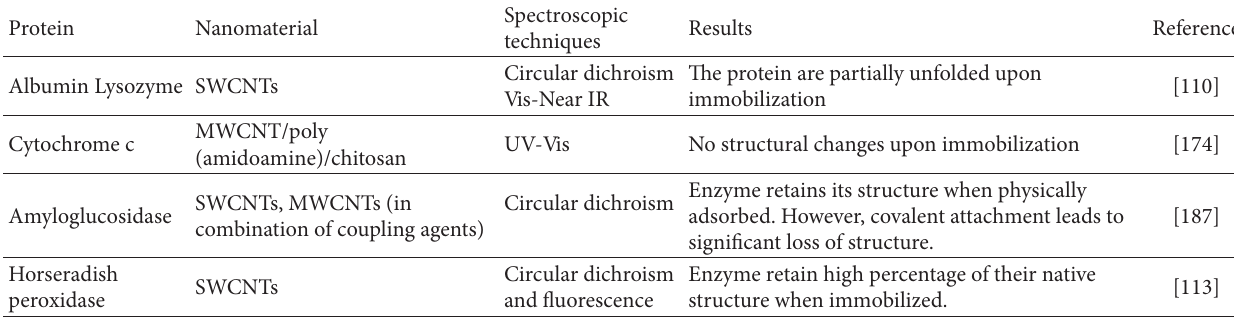
T 7: Structural studies of protein immobilized onto carbon